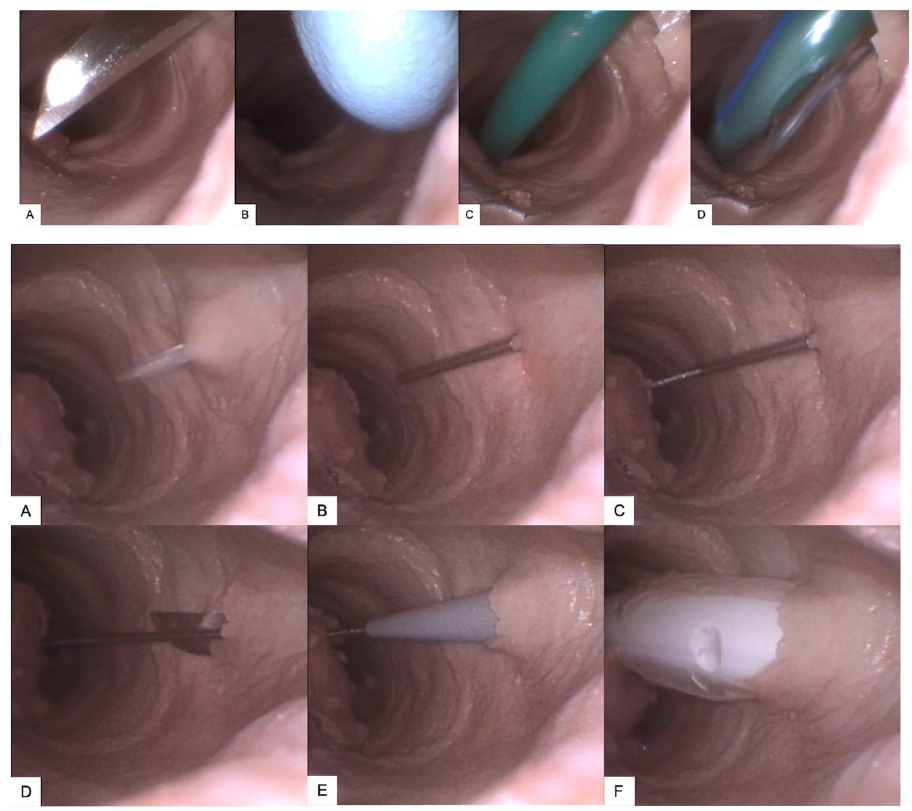
Fig 2. A . Representative bronchoscopic images of scalpel technique . (A) Scalpel insertion into tracheal lumen; (B) Blunt plastic end of scalpel seen in tracheal lumen, enlarging scalpel incision before insertion of bougie; (C) Bougie insertion; (D) Insertion of 6.0 endotracheal tube over bougie. B . Representative bronchoscopic images of Seldinger technique. (A) Needle insertion; (B) Needle appropriately directed inferiorly before wire insertion; (C)